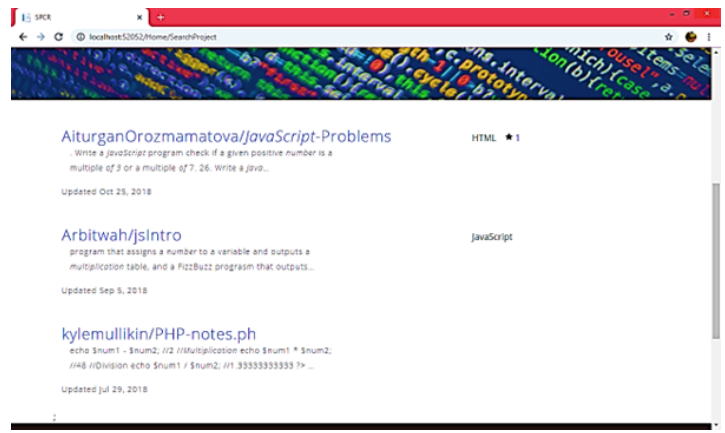
Figure 11. Crawled